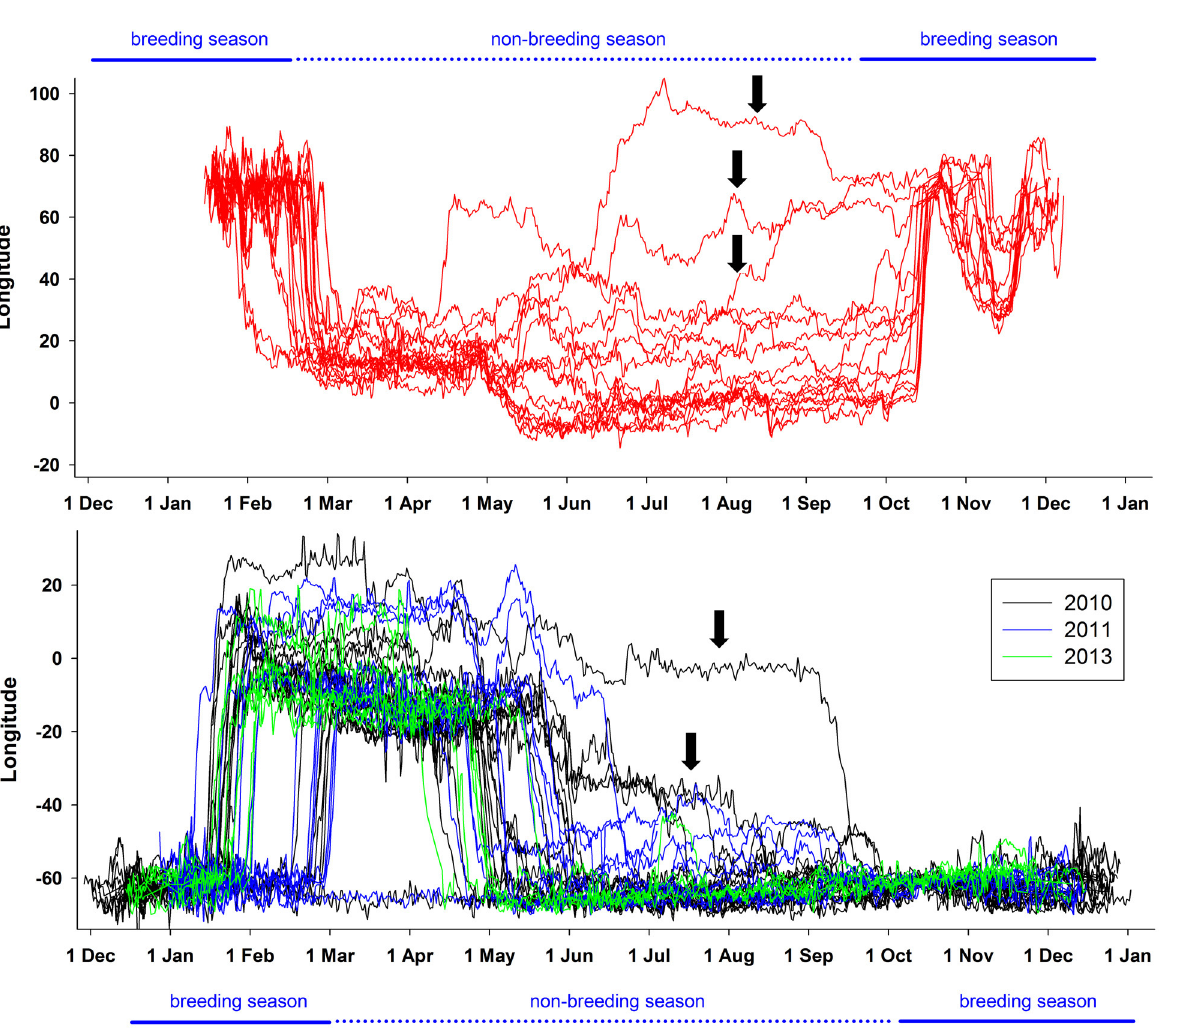
Fig 5. Individual variability of year-round longitudinal positions of Thin-billed prions. Birds were tracked using geolocators, from Kerguelen (upper panel, in red) and the Falkland Islands (lower panel). Birds exhibiting unusual migration timing are marked with